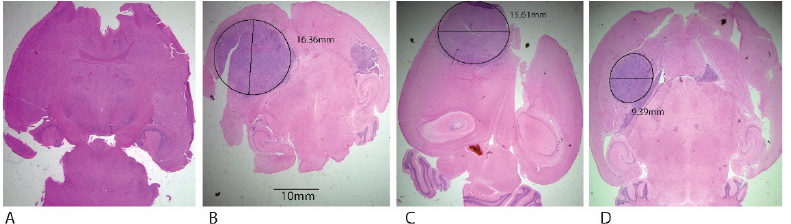
Figure 16. Comparison of the hematoxylin and eosin (H&E) staining in XM-S mice model after drug treatment ( A ) Negative control with no tumor, ( B ) Positive control after no drug treatment, ( C ) Tumor size after treatment with TMZ solution. ( D ) Tumor size after treatment with SLNP-TMZ. All the photographs were produced using light microscopy at 4X magnification.